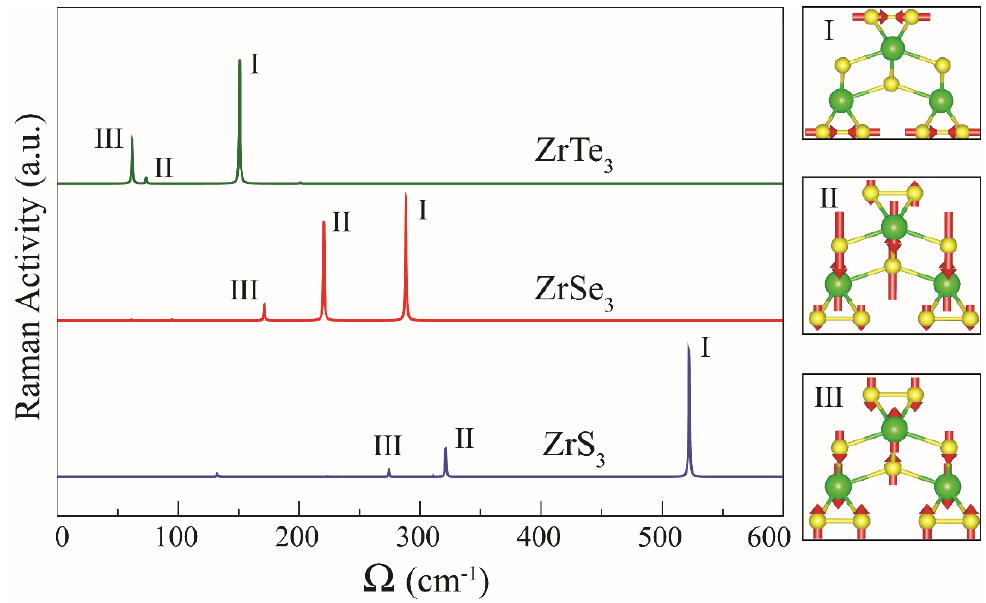
Figure 3. The Raman spectrum of each monolayer ZrX 3 structure (on the left) and the vibrational characteristic of the individual atoms for the most prominent Raman active modes (on the right).